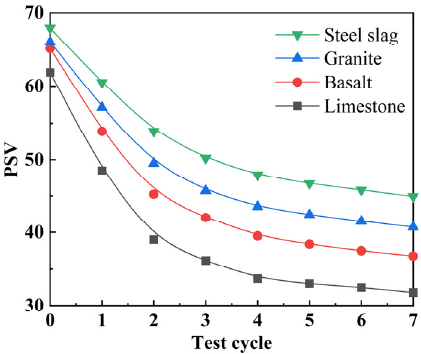
Figure 3. PSV attenuation curves.